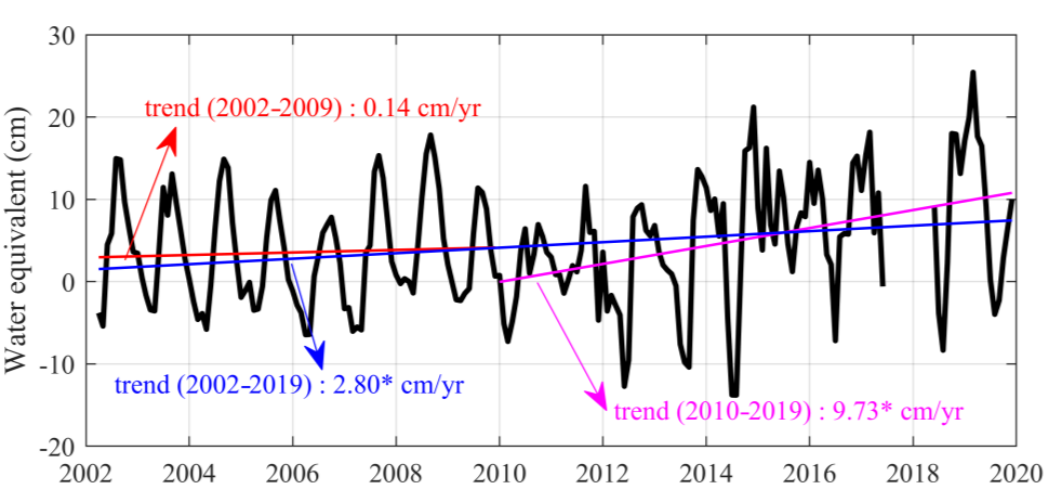
Figure 8. Groundwater storage anomaly (GWSA) in the study region. The vacant part of the time series indicates the intermission gap between GRACE and GRACE-FO. Asterisk (*) refer to statistically significant values ( p -value <